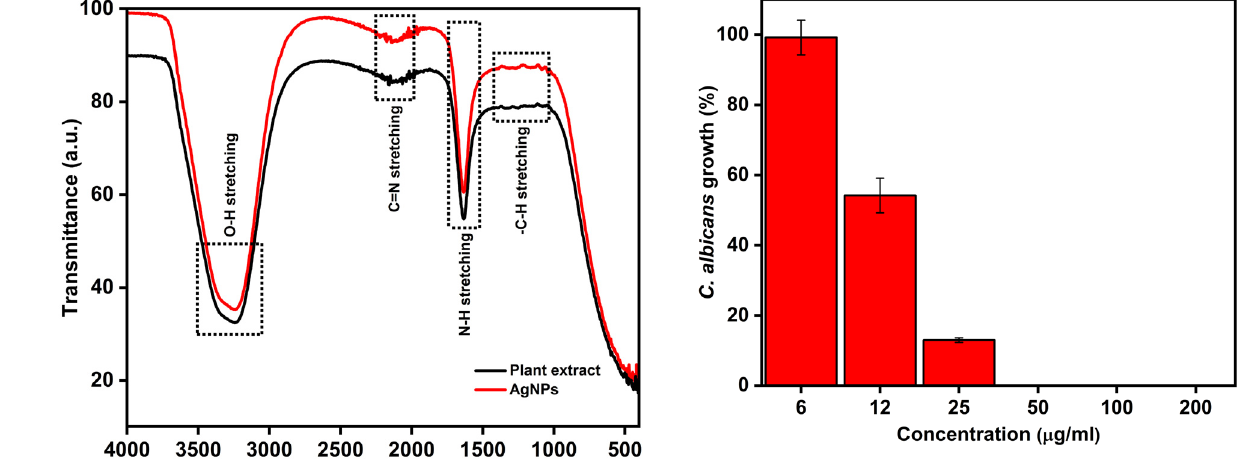
Figure 4: Antifungal studies using the microdilution method, and the graph shows the dose - dependent e ff ect ( n = 36 ) .